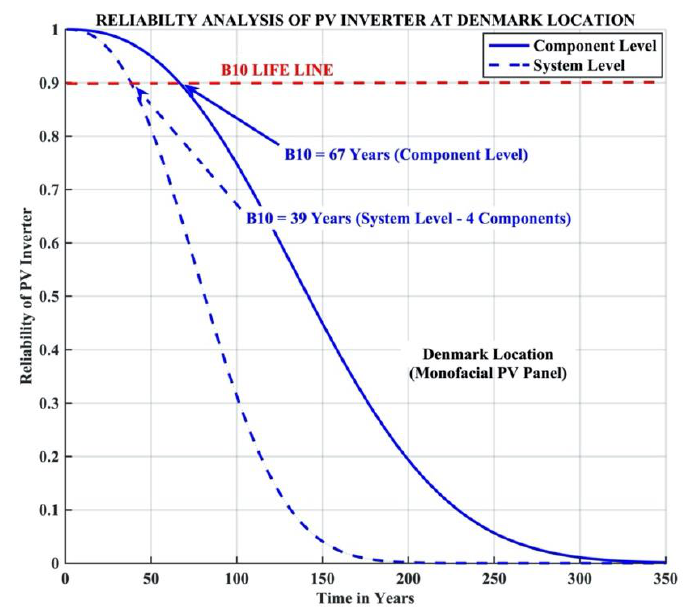
Figure 14. Reliability function of the PV inverter at the location in Denmark.